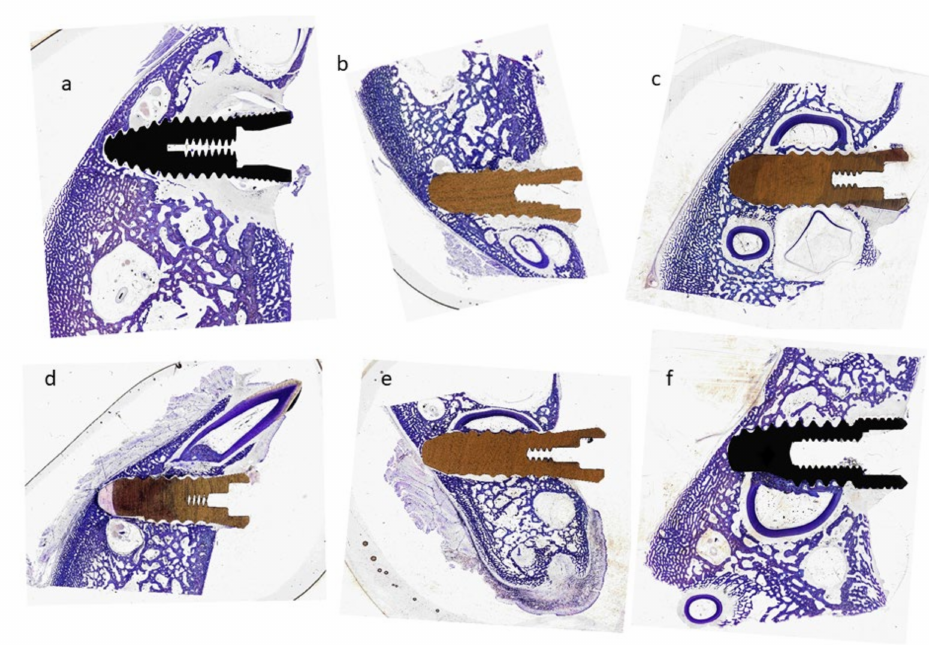
Figure 5. Histologies of the dental implants (Ti, ZrO 2 and Ti-R) inserted in the tibiae of minipigs for 4 and 12 weeks. ( a ) Ti dental implant for 4 weeks. ( b ) ZrO 2 dental implant for 4 weeks. ( c ) Ti-R dental implant for 4 weeks. ( d ) Ti dental implant for 12 weeks. ( e ) ZrO 2 dental implant for 12 weeks. ( f ) Ti-R dental implant for 12 weeks.